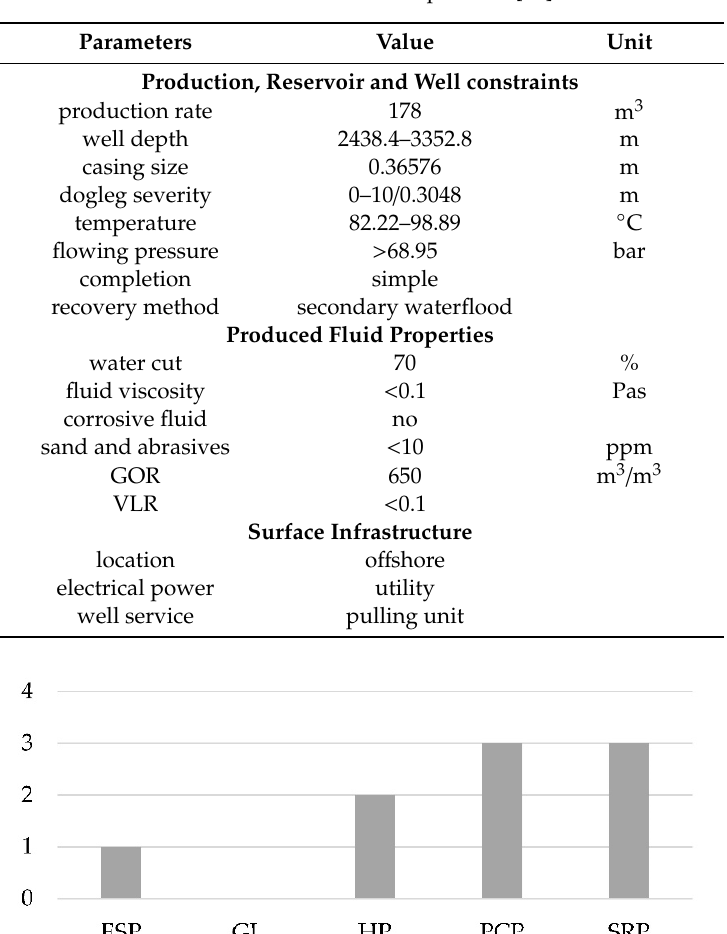
Table 4. Salman oil field input data [12].